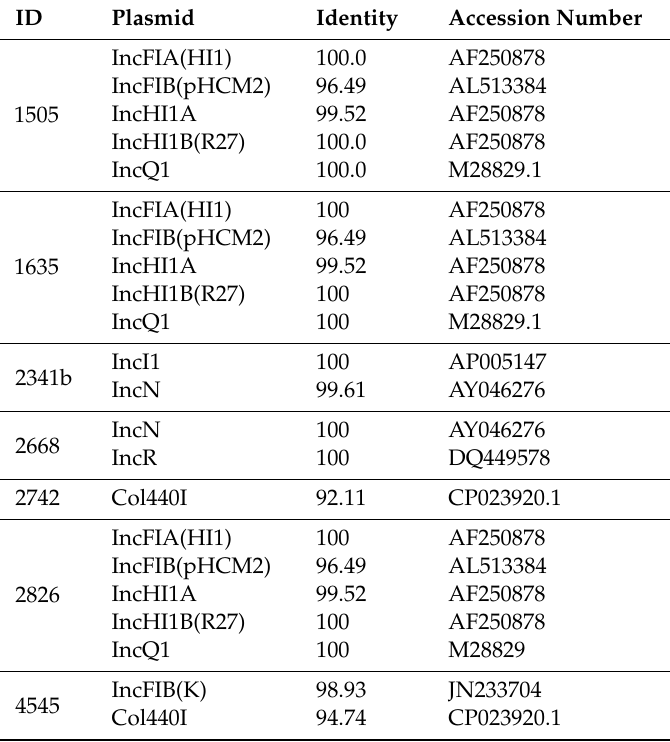
Table 2. Identified plasmids in Klebsiella isolates.